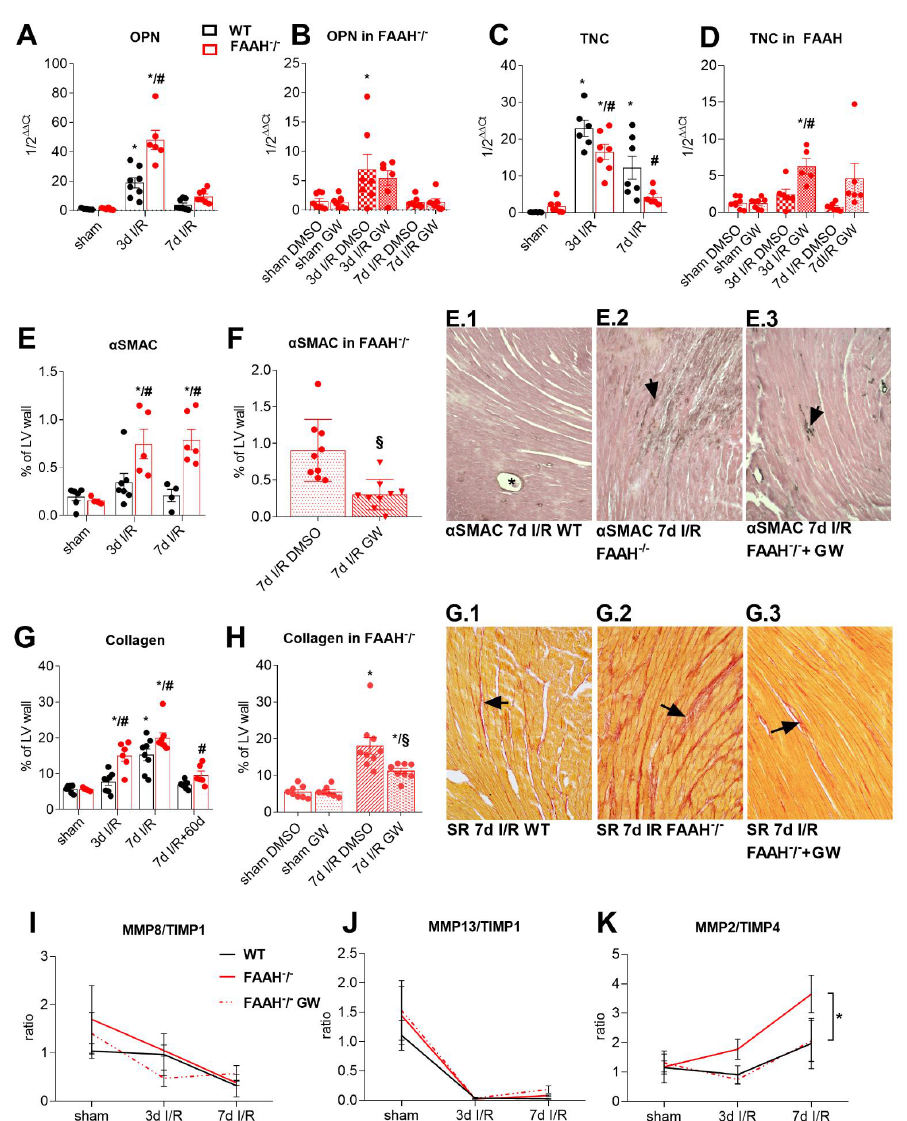
Figure 4. Fatty acid amide hydrolase deficiency induces stronger extracellular matrix remodeling with high myofibroblasts accumulation and collagen deposition. ( A ) Macrophage differentiation marker OPN was increased in FAAH − / − group and ( B ) normalized with GW6471. ( C ) The mRNA expression of remodeling-related mediator tenascin-C was significantly lower in FAAH − / − group after I/R compared to WT, and ( D ) restored after GW6471 treatment. ( E ) Intensified remodeling with high myofibroblasts accumulation observed in FAAH − / − mice ( F ) was diminished using GW6471, as also shown in representative α SMAC staining in panels ( E.1 – E.3) , arrows show α SMAC positive myofibroblasts; asterisk in E1: small arteriole with α SMAC positive tunica muscularis. ( G ) Collagen deposition was increased in FAAH − / − group after I/R and ( H ) reduced when FAAH − / − mice were treated with GW6471. Representative Picro Sirius red staining in ( G.1 – G.3 ), arrows indicate collagen deposition. ( I ) MMP8/TIMP1 ratio shows decreasing tendency ( J ) together with MMP13/TIMP1 ratio, while ( K ) MMP2/TIM4 ratio shows increasing tendency. RT-qPCR using Taqman ® , expression is related to sham and GAPDH using comparative ∆∆ Ct method. Magnification in ( E.1 – E.3 , G.1 – G.3 ): 200 × . α SMAC, alpha Smooth Muscle Actin; DMSO, Dimethyl sulfoxide; FAAH, fatty acid amide hydrolase; MMP2, matrix metalloproteinase-2; OPN, osteopontin; TNC, tenascin-C; WT, wild-type. *, p < 0.05 vs. respective sham; #, p < 0.05 FAAH − / − vs. WT at respective time point; §, FAAH − / − +GW vs. FAAH − / − +DMSO at the respective time point.; Panel ( K ) *, p < 0.05 for 7d I/R WT vs. 7d I/R FAAH − / −